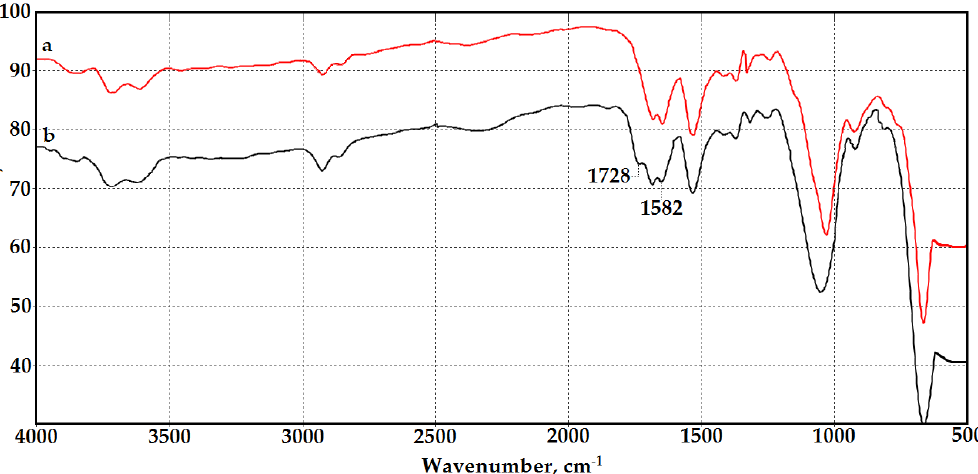
Figure 2. FTIR spectra of the original chitosan aerogel ( a ) and chitosan aerogel modified with poly(GMA-co-HeMA) copolymers ( b ).